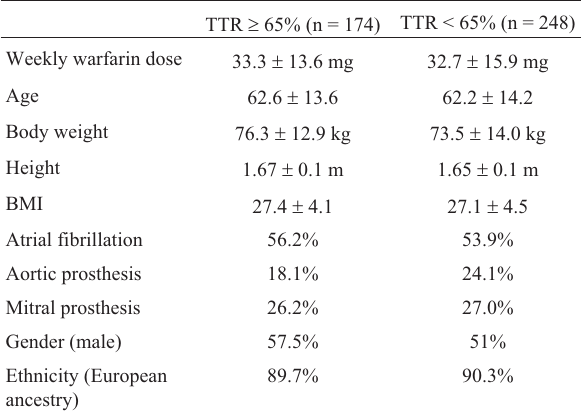
Table 1 - Clinical and demographic characteristics of patients according to TTR.